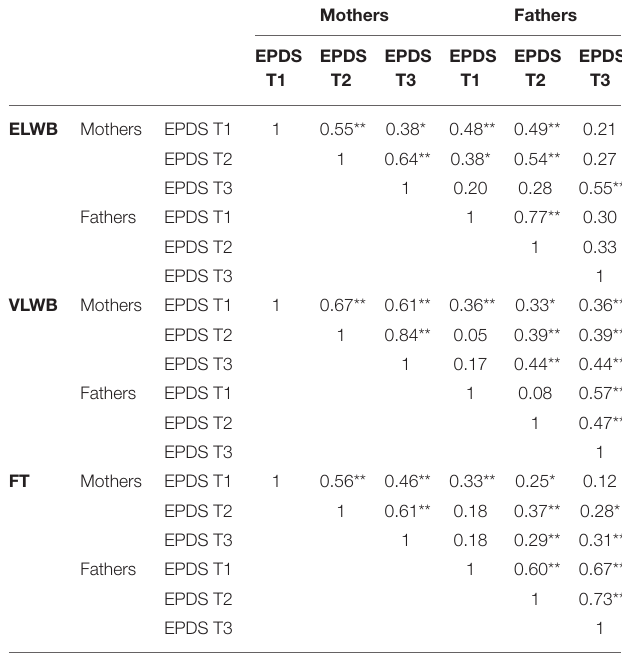
TABLE 3 | Pearson correlation analysis on EPDS scores at T1, T2 and T3 in mothers and fathers according to birth weight. Mothers